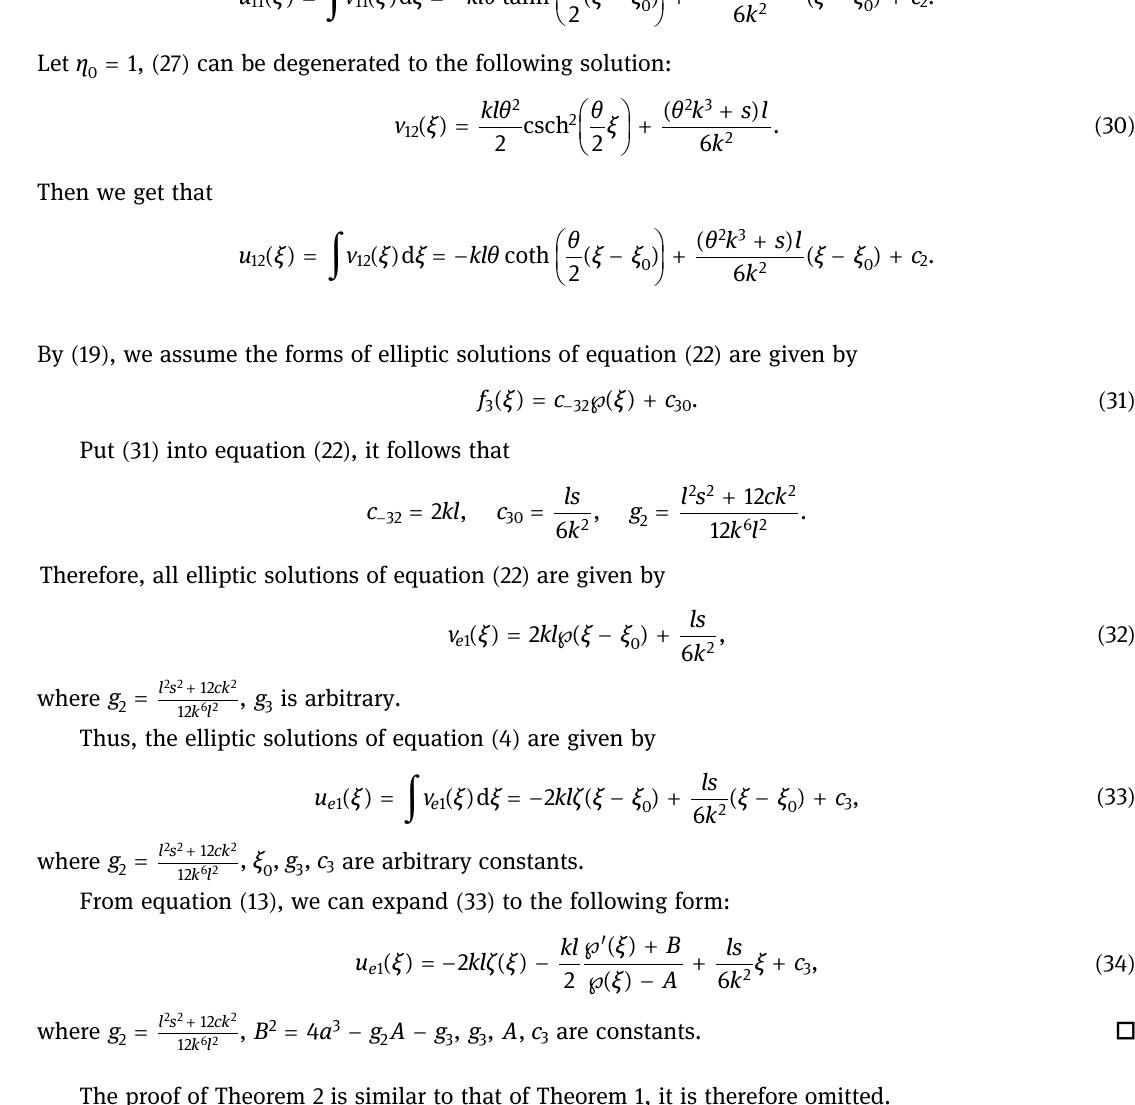
, θ 2 = when t −5 = in ( a ) , t 0 = in ( b ) , t 5 = in ( c ) 0 =